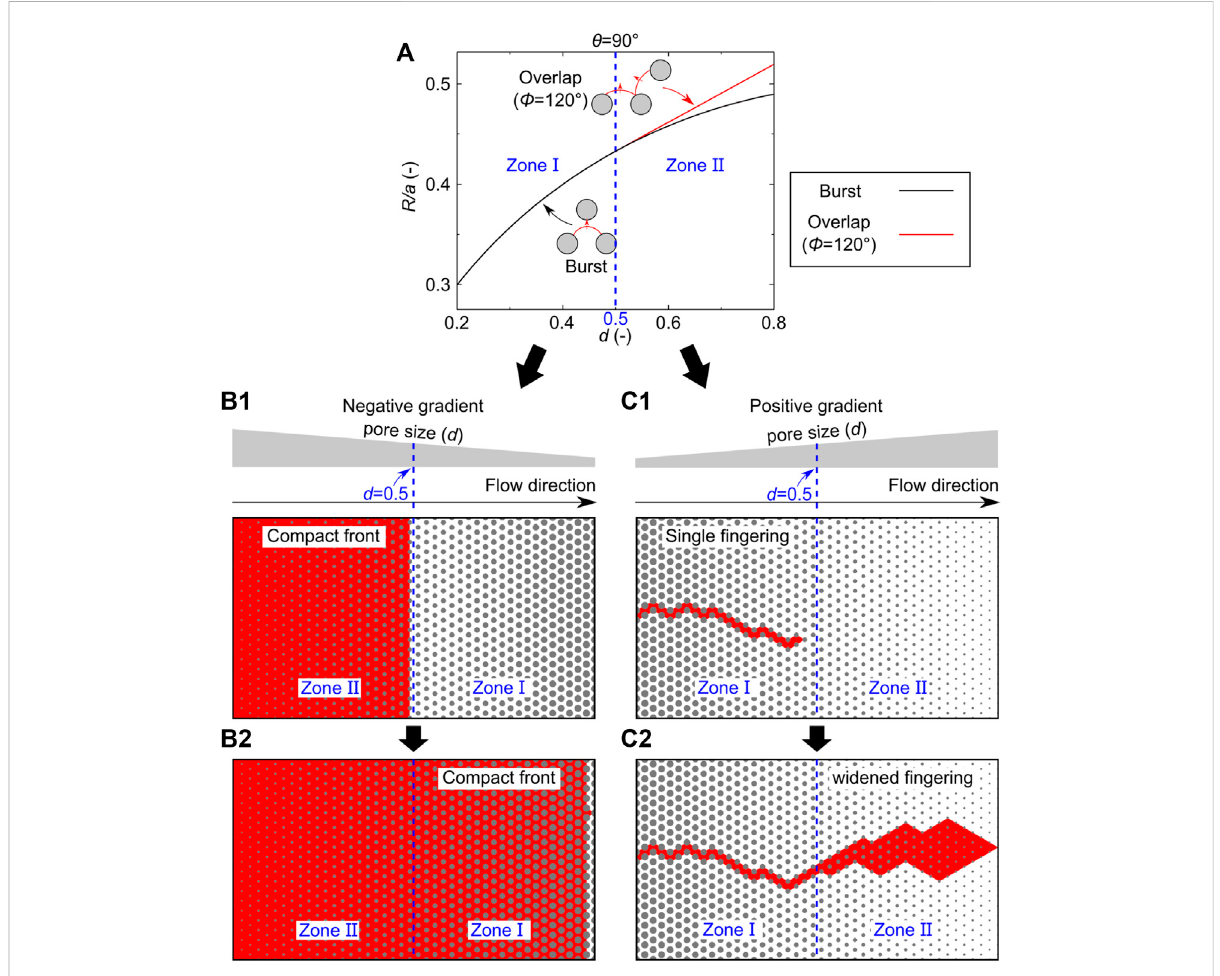
FIGURE 3 Linking pore- fi lling events to local invasion morphologies at θ = 90 ° . (A) Critical radius of curvature of pore- fi lling events varies with pore size. The blackline represents theburstevent, andthered linerepresentstheoverlap event. Only theburstevent occurs inzone Ⅰ (0.2 ≤ d ≤ 0.5),and both the burst event and overlap event occur in zone Ⅱ (0.5 < d ≤ 0.8). (B) In negative gradient porous media, the invading phase invades from zone Ⅱ to zone Ⅰ .Theinvasioninbothzonesformsacompactinvadedregion. (C) Inpositivegradientporousmedia,theinvadingphaseinvadesfromzone Ⅰ to zone Ⅱ . (C1) In the beginning, a single fi ngering is obtained. (C2) After the invading phase reaches zone Ⅱ , the fi ngering is widened by the overlap